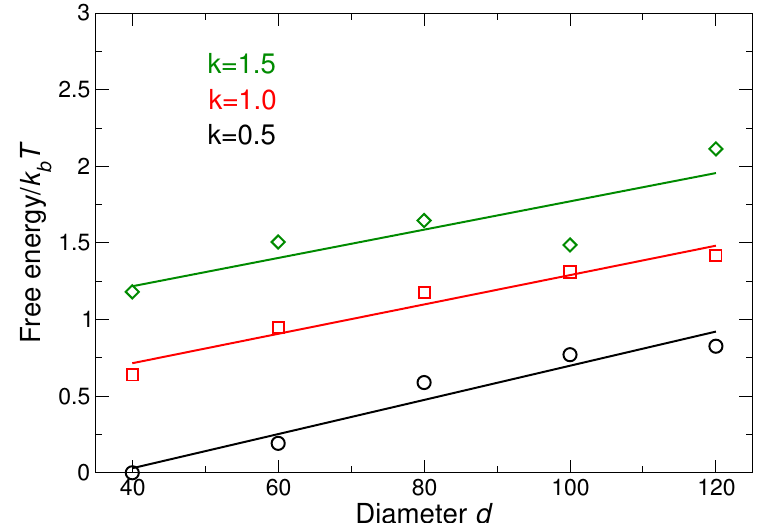
Figure 6. Difference in free energy of the lattice for different DNA stiffness values as a function of NP size; the reference system is the system with smallest NP size and k a = 0.5. Increasing NP size increases the free energy, which means a relative decrease in stability. Similarly, increasing stiffness increases free energy (reduces